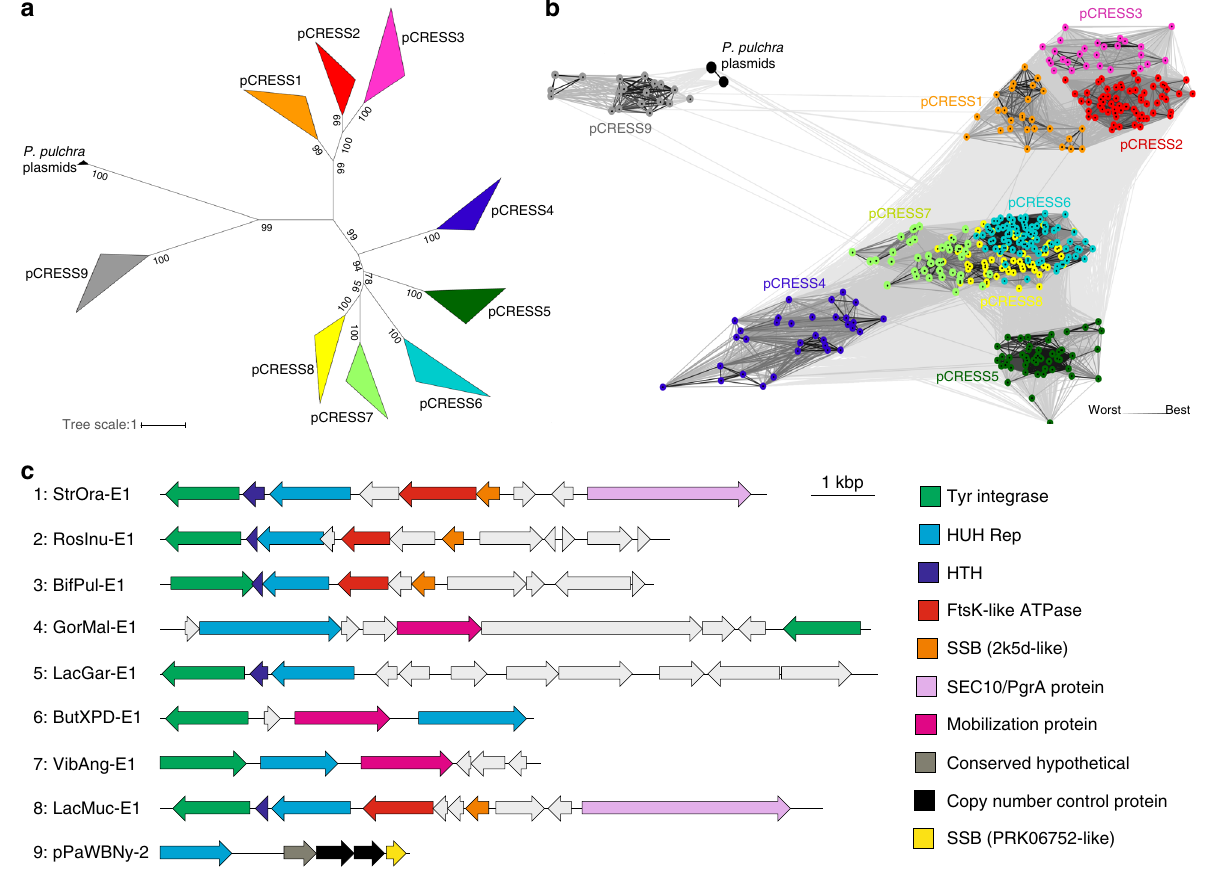
Fig. 2 Diversity of viral-like Rep proteins in bacteria. a Phylogenetic tree of bacterial Rep proteins and their homologs in P. pulchra . Closely related sequences are collapsed to triangles, whose side lengths are proportional to the distances between closest and farthest leaf nodes. b CLANS groups of bacterial Rep proteins and their homologs. Nodes indicate protein sequences. Lines represent sequence relationships (CLANS P -value ≤ 1e − 05). The nodes belonging to the same cluster are colored with the same colors, corresponding to the clades shown in panel A. c Genome maps of integrated and extrachromosomal plasmids representing groups 1 – 9. Homologous genes are depicted using the same color and their functions are listed on the right